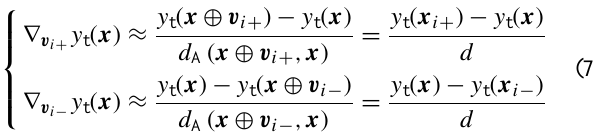
; illus- , B 0 and B 0 2 3 1 , B 0 and B 0 . 1 2 3